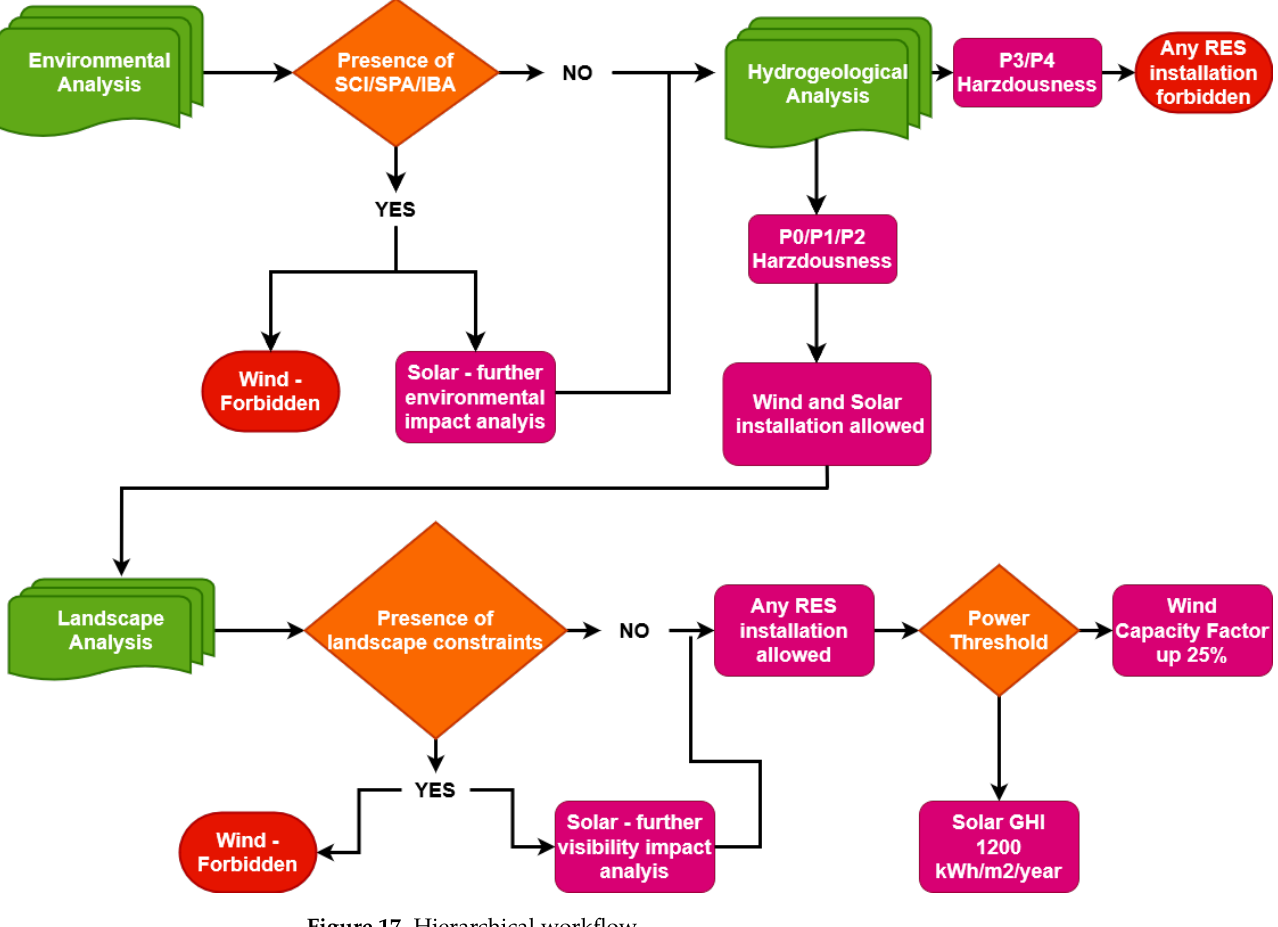
Figure 17. Hierarchical